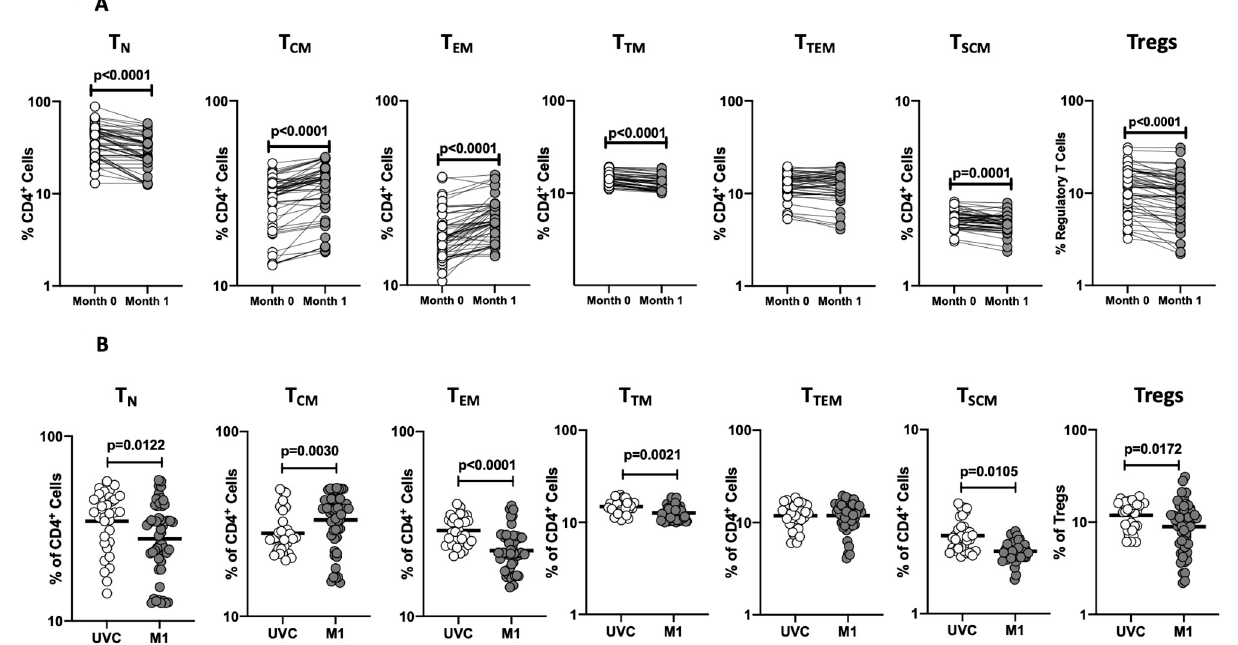
Fig 1. BCG vaccination is associated with altered frequencies of CD4 + T cell memory subsets and regulatory cells. (A) Frequencies of CD4 + T cell subsets in BCG pre-vaccinated [M0] (n = 54) and month 1 following vaccination [M1] (n = 54). Data are shown as line diagrams with each line representing a single individual. p values were calculated using the Wilcoxon matched pair tests with Holms correction for multiple comparisons. (B) Frequencies of CD4 + T cell subsets in BCG unvaccinated (UVC) (n = 32) and post vaccinated [M1] (n = 54) individuals. The data are represented as scatter plots with each circle representing a single individual. p values were calculated using the Mann-Whitney test with Holm’s correction for multiple comparisons.